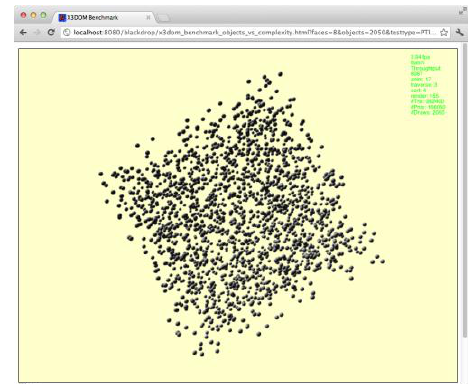
Figure 3: The spheres used for the abstract